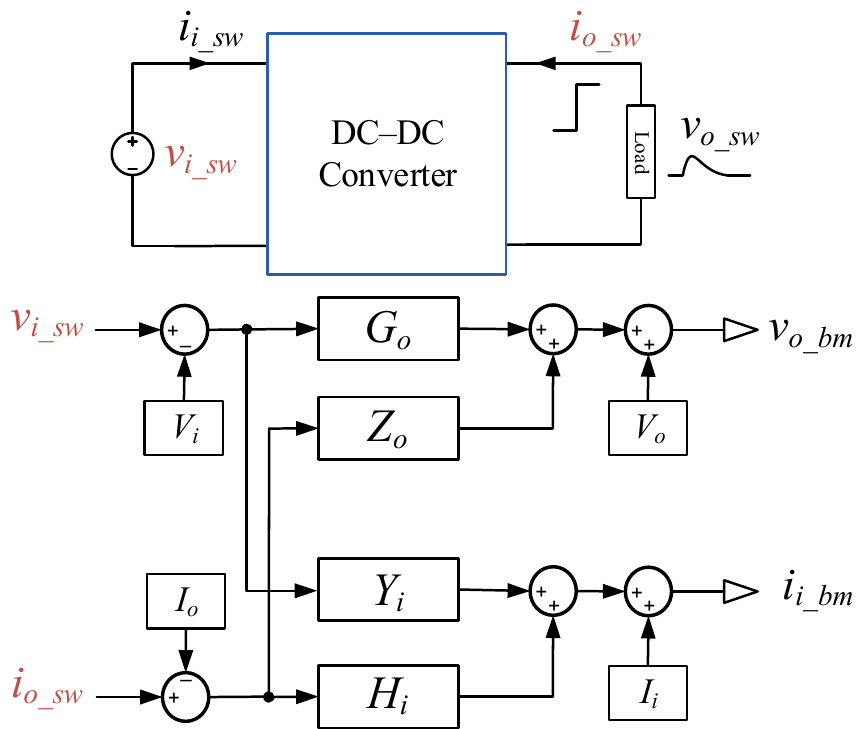
Figure 6. Behavioral model verification for the dc–dc converter.